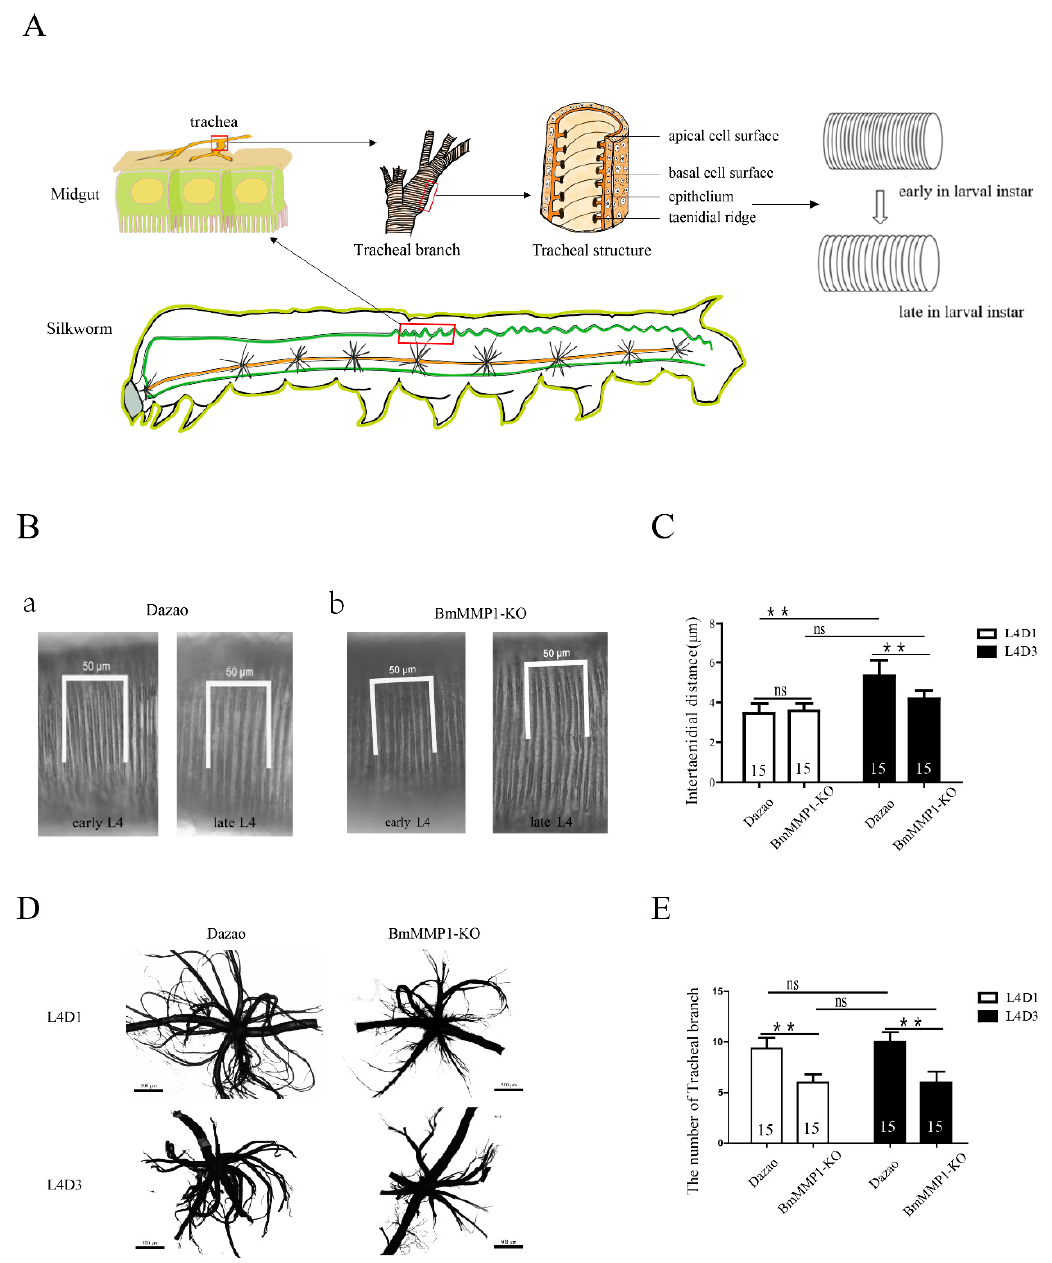
Figure 3. Taenidial spacing expands requires BmMMP1. ( A ) Distribution and structure of trachea of B. mori . The scissor images were obtained using the Easy Paint Tool SAI 1.3.6. ( B ) Tracheal cuticle expansion of WT(a) and BmMMP1-KO type(b) in the fourth larval instar. ( C ) Statistics of intertaenial distance, the white pillars represent early L4 or L4D1, the first day of fourth larval instar; the black pillars represent late L4 or L4D3, the third day of fourth larval instar. ( D , E ) The number of tracheal branches in early L4 and late L4. n = 15. (ns, p ≥ 0.05; * *, p < 0.01).